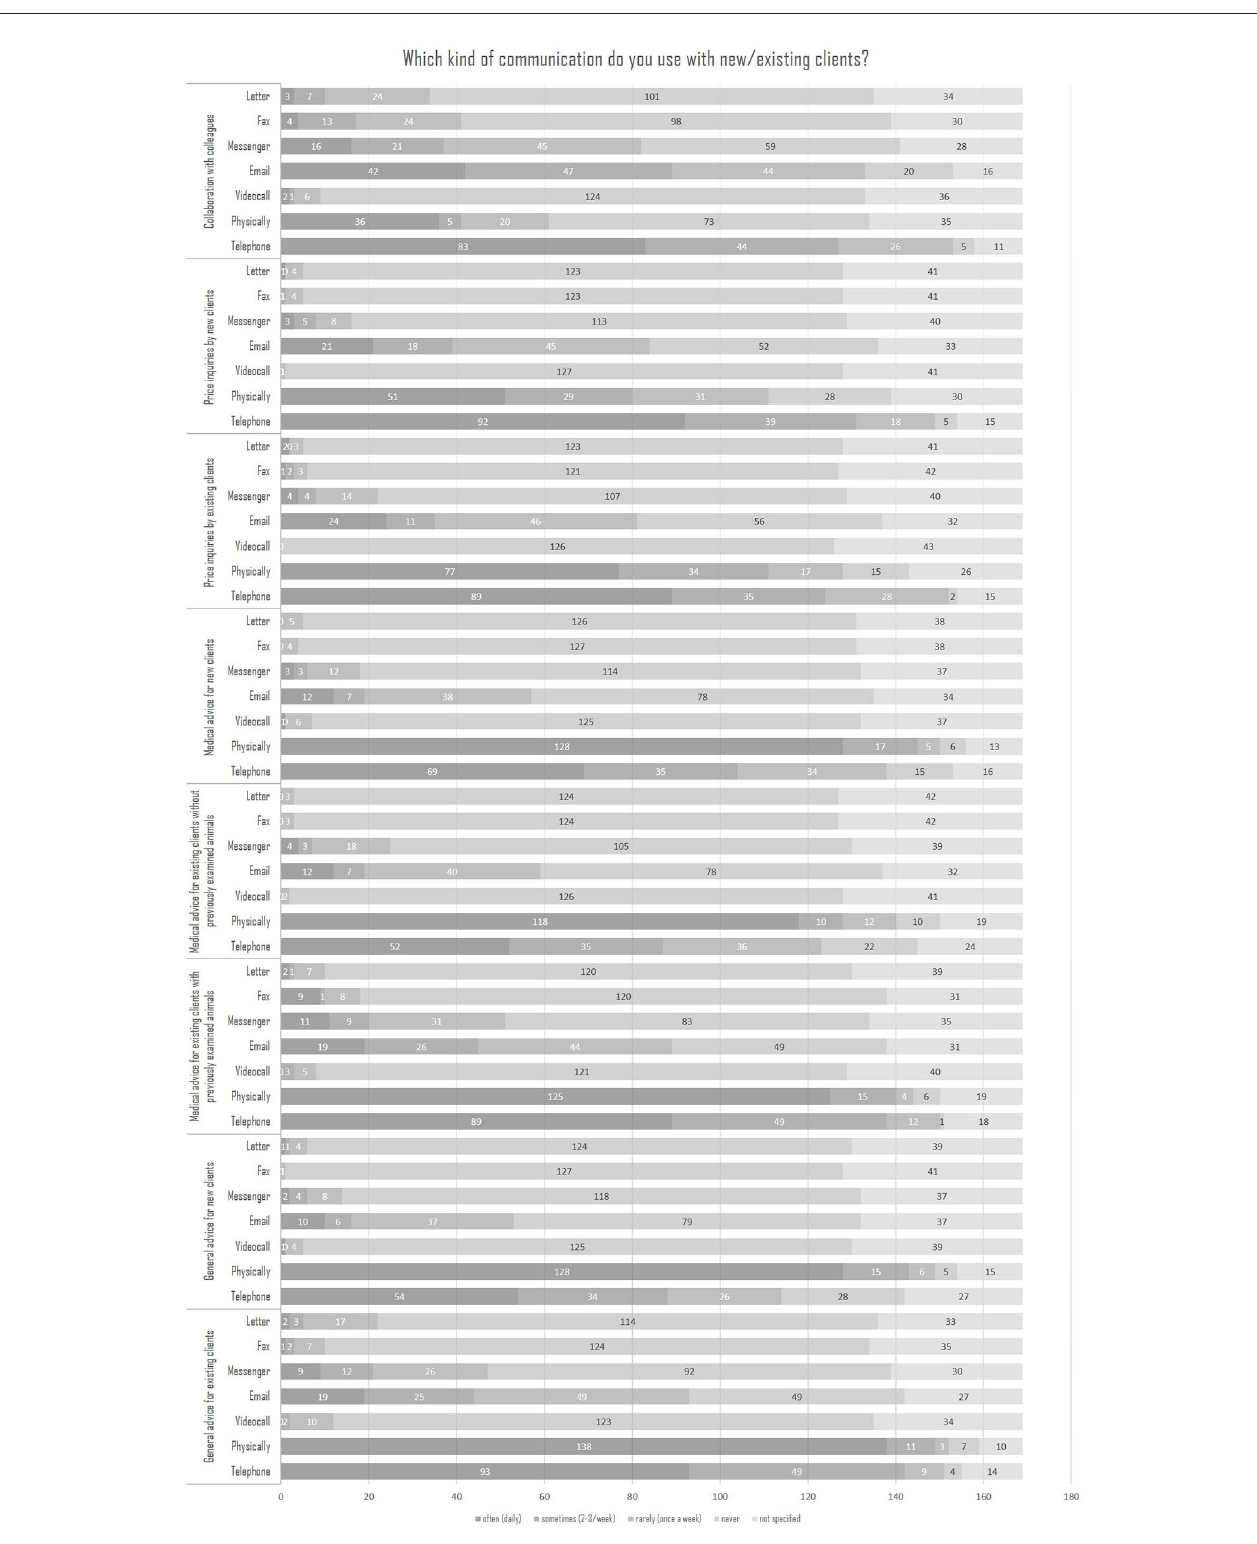
FIGURE6 Kind of communication regarding new or existing customers ( N =